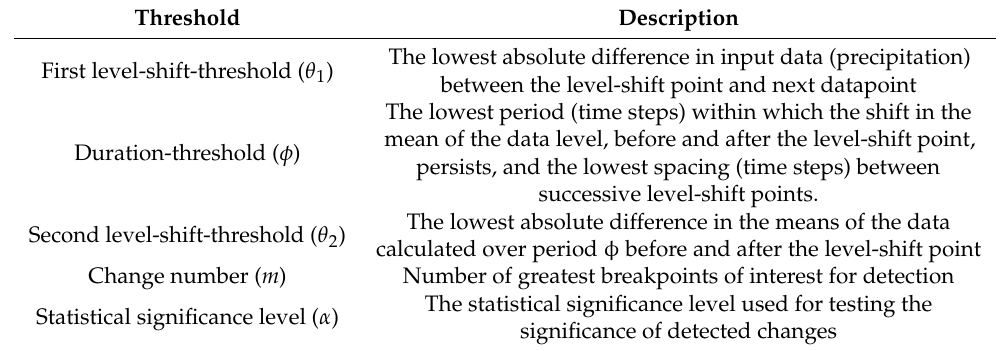
Table 1. User-defined thresholds in the DBEST’s change detection algorithm [Adapted from